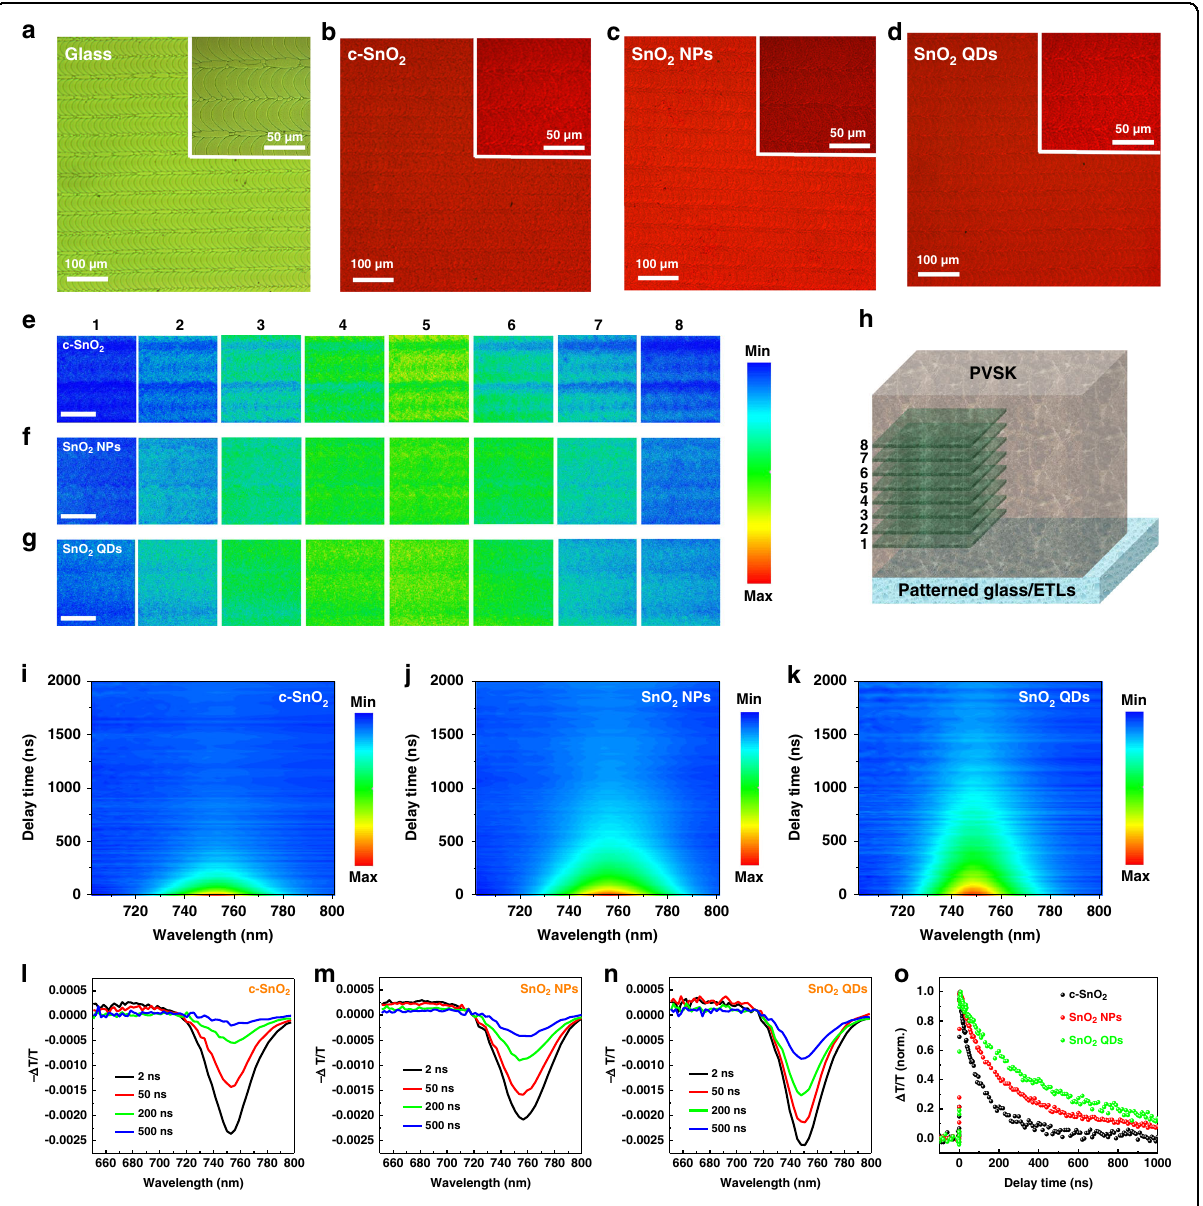
Fig. 4 Local investigations on PVSK thin fi lms on various substrates. Optical microscopy images of a patterned glass, b patterned glass/c-SnO 2 / PVSK, c patterned glass/SnO 2 NPs/PVSK, and d patterned glass/SnO 2 QDs/PVSK. Insets are the corresponding high magni fi cation images. Spatial confocal luminescence microscope screenshot at λ excitation = 633 nm of e patterned glass/c-SnO 2 /PVSK, f patterned glass/SnO 2 NPs/PVSK, and g patterned glass/SnO 2 QDs/PVSK. Scale bar is 50 µm. h Schematic pro fi le of depth-dependent spatial confocal luminescence image acquired from different regions (level 1 – 8) in the Z direction. i – k 2D contour plots of transient absorption (TA) results pumped by 532 nm with fl uence as low as 0.27 µJ cm − 2 . l – n representative TA spectra at selected delay times. o Normalized decay dynamics of ground-state-bleach signals of each sample. TA measurements are performed under room temperature and samples are protected by nitrogen